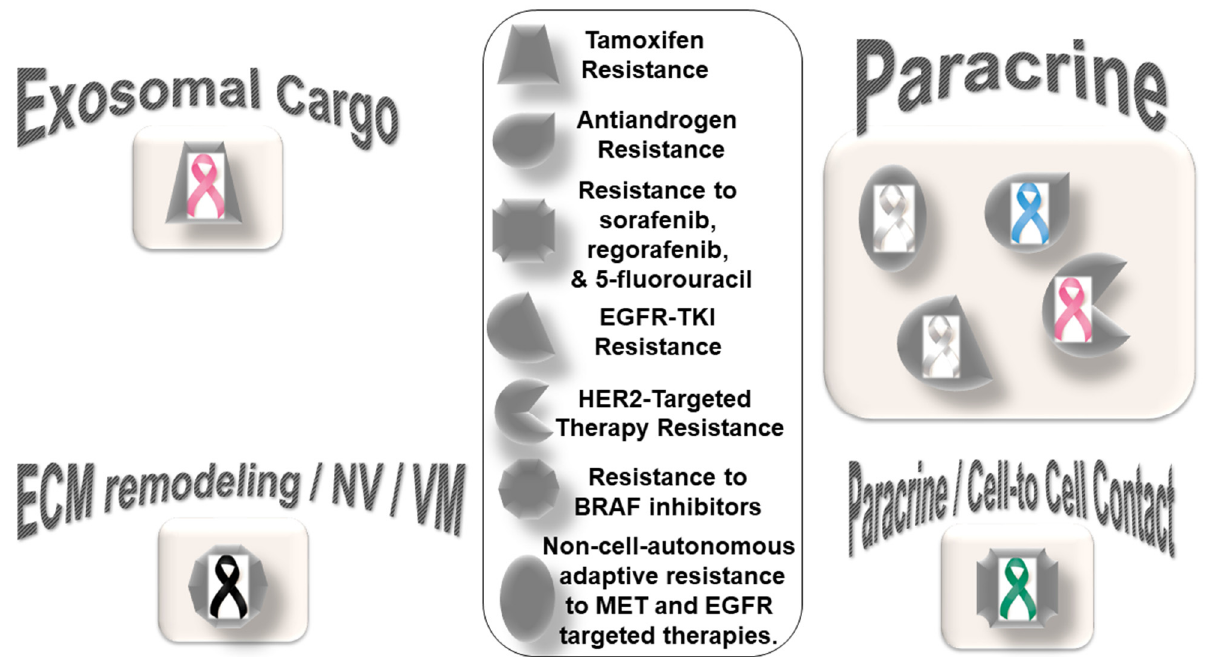
Figure 2. Distribution pattern of types of resistance to targeted therapy based on specific mediators of CAF functions in solid tumors: The four types of mediators of action employed by CAFs to orchestrate the development of resistance to targeted therapy are presented in the cartoon. The most common mode of interaction is paracrine, wherein CAFs signal to either tumor cells or other components of the TME via characteristic secretome. In addition to the involvement of characteristic secretome, exosomal cargos delivering different miRNAs that target various cell signaling proteins are common mediators of CAF action. The sizes of the boxes indicate the number of studies in each box. The shapes indicate the types of resistance in different tumors (inset). Organ tumors are indicated by their respective ribbon colors. Lung cancer: white or pearl; skin cancer: black. liver cancer: emerald green; breast cancer: pink; prostate cancer: light blue.